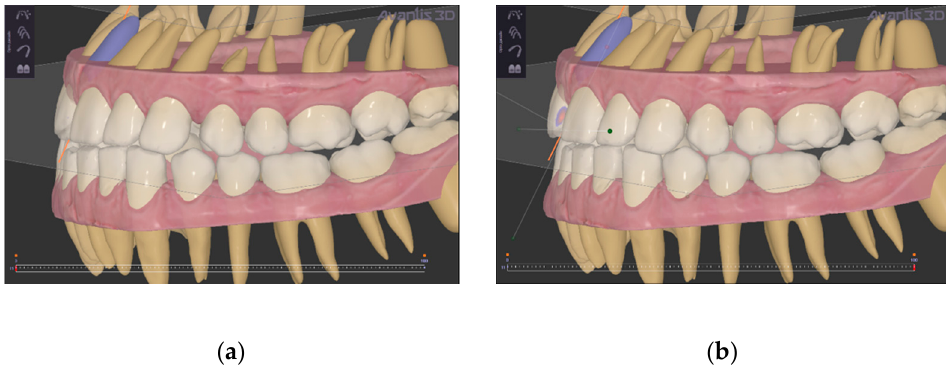
Figure 7. Virtual teeth alignment. ( a ) before virtual alignment; ( b ) after virtual alignment.